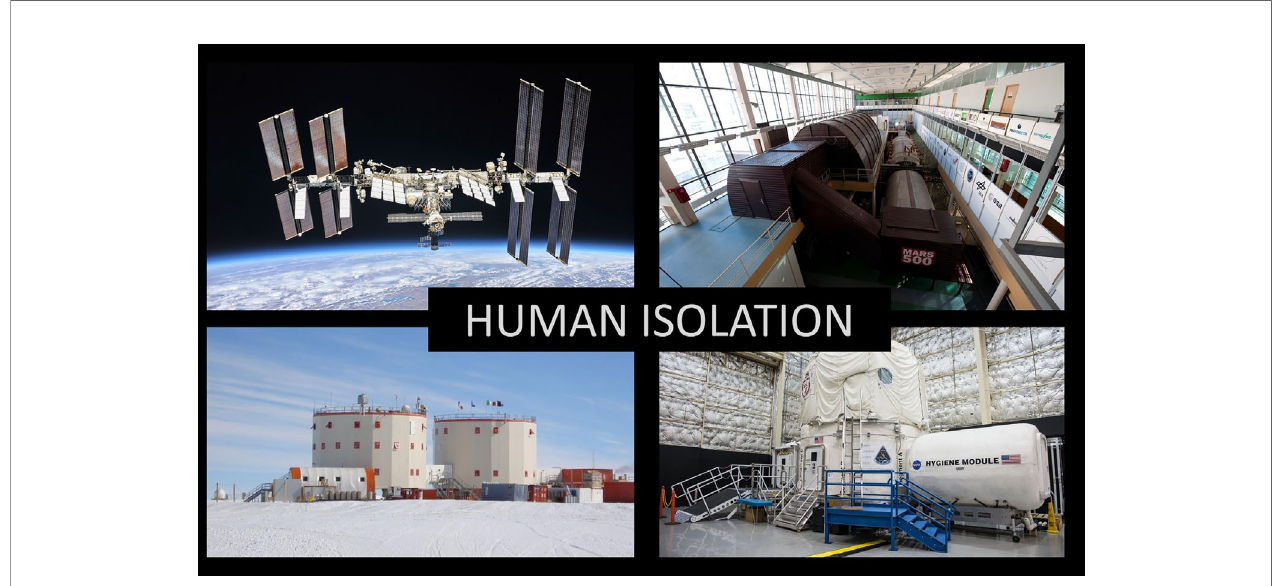
FIGURE 1 | Human isolation facilities. On the left side of the picture displayed the ISS and the Antarctic station (Concordia) . On the right side “ terrestrial spacecrafts ” : HERA (at the top of the picture) and NEK (at the bottom of the picture).